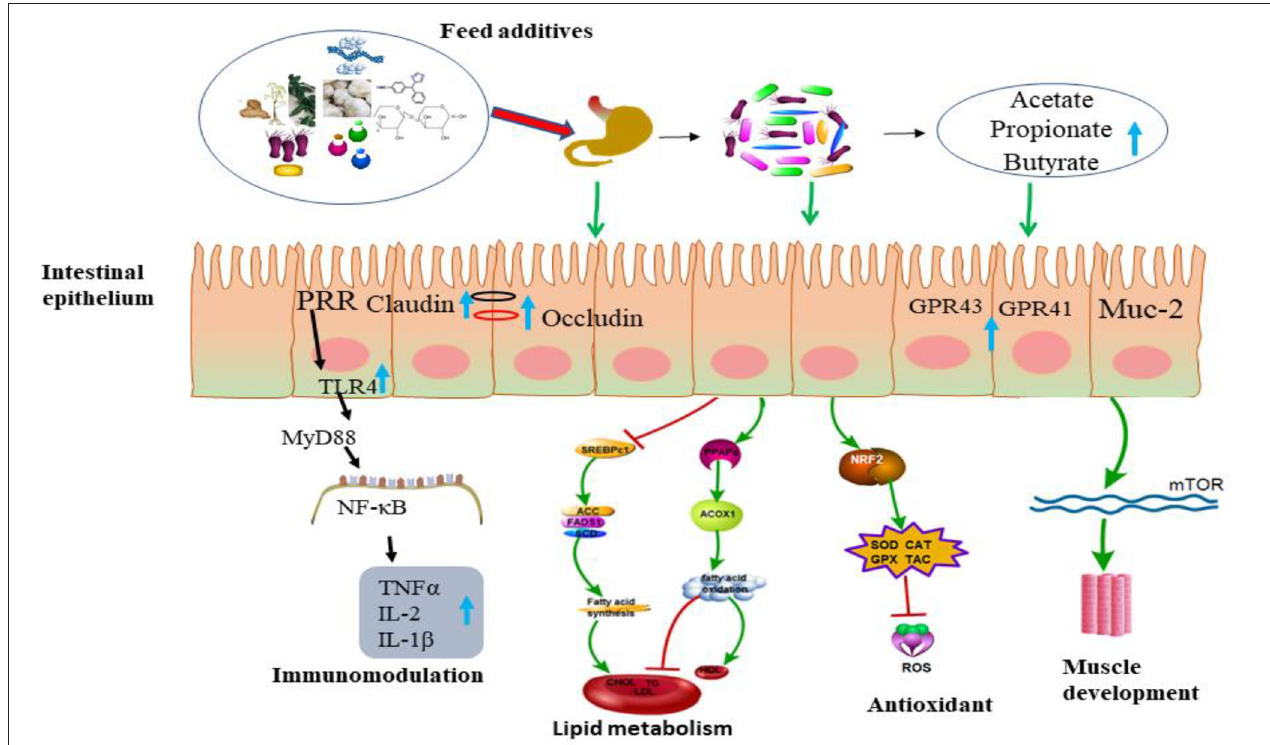
FIGURE 2 | Schematic diagram of an alternative feed additive mode of